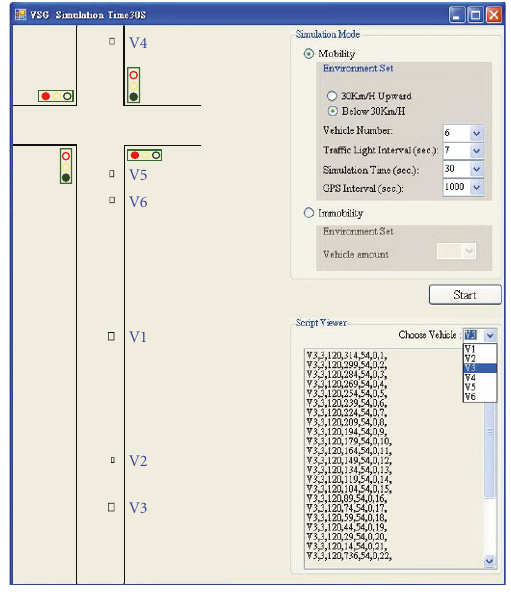
Figure 4: The screen shot of VSG tool.